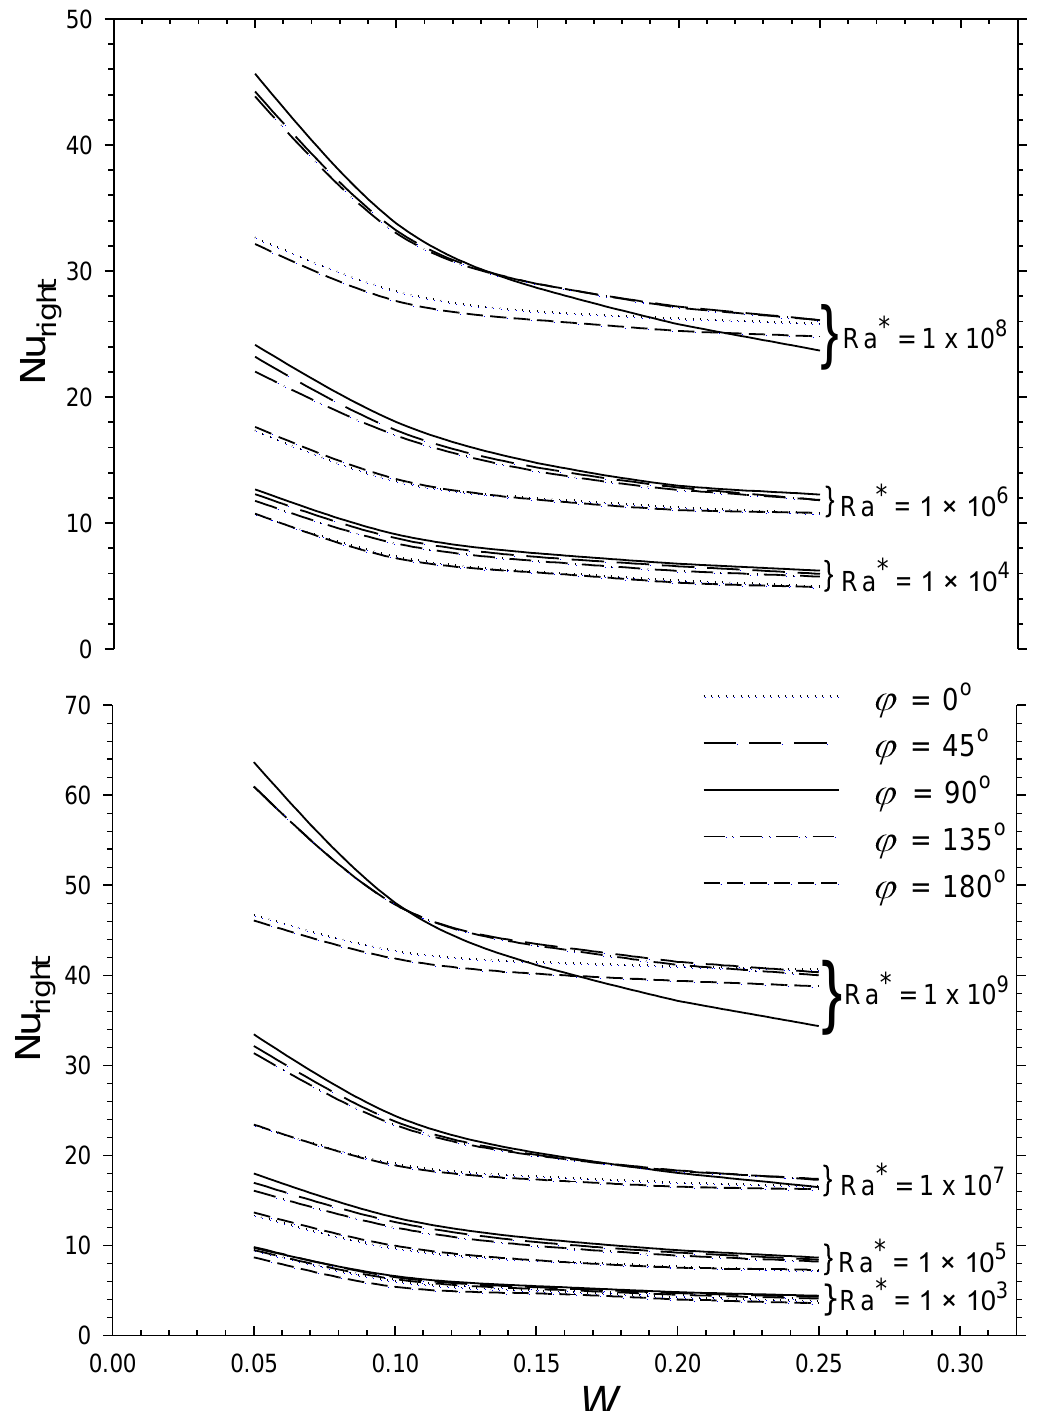
Figure 8. Variations in the mean Nusselt number of the right-side surface of the slender cuboid with dimensionless width, W , for different values of the heat flux Rayleigh number, Ra *, and positions, φ .